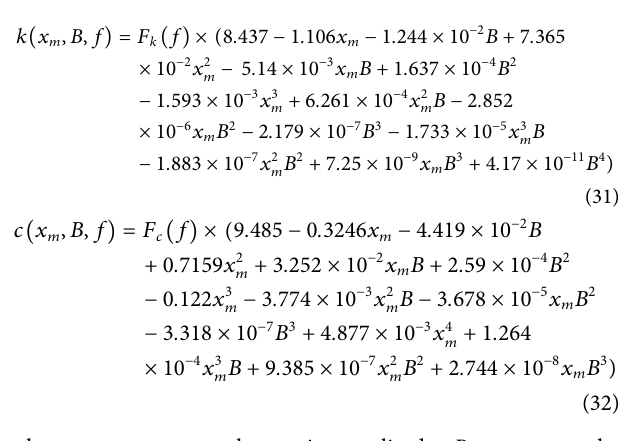
Frontiers in Materials |